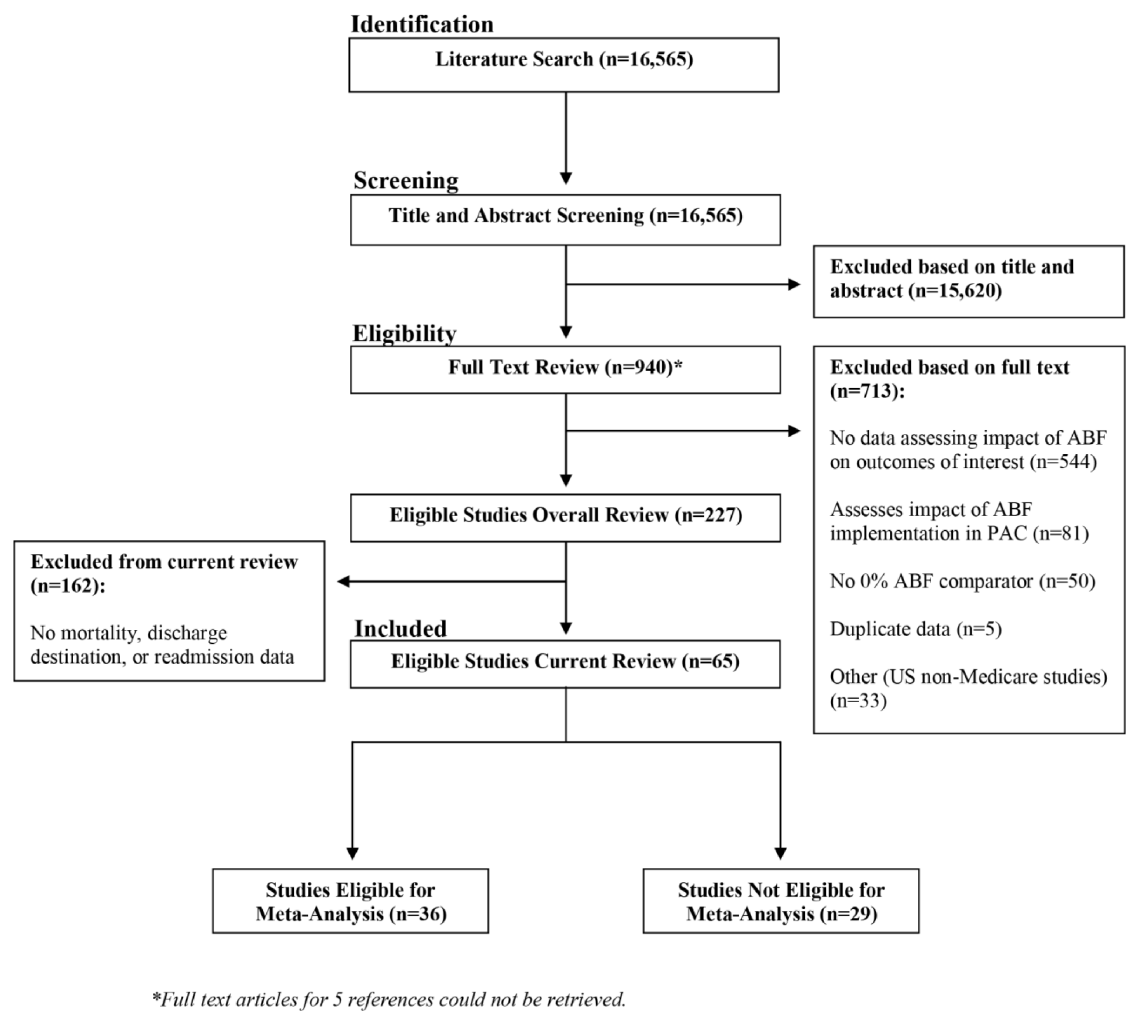
Figure 1. Prisma flow diagram.